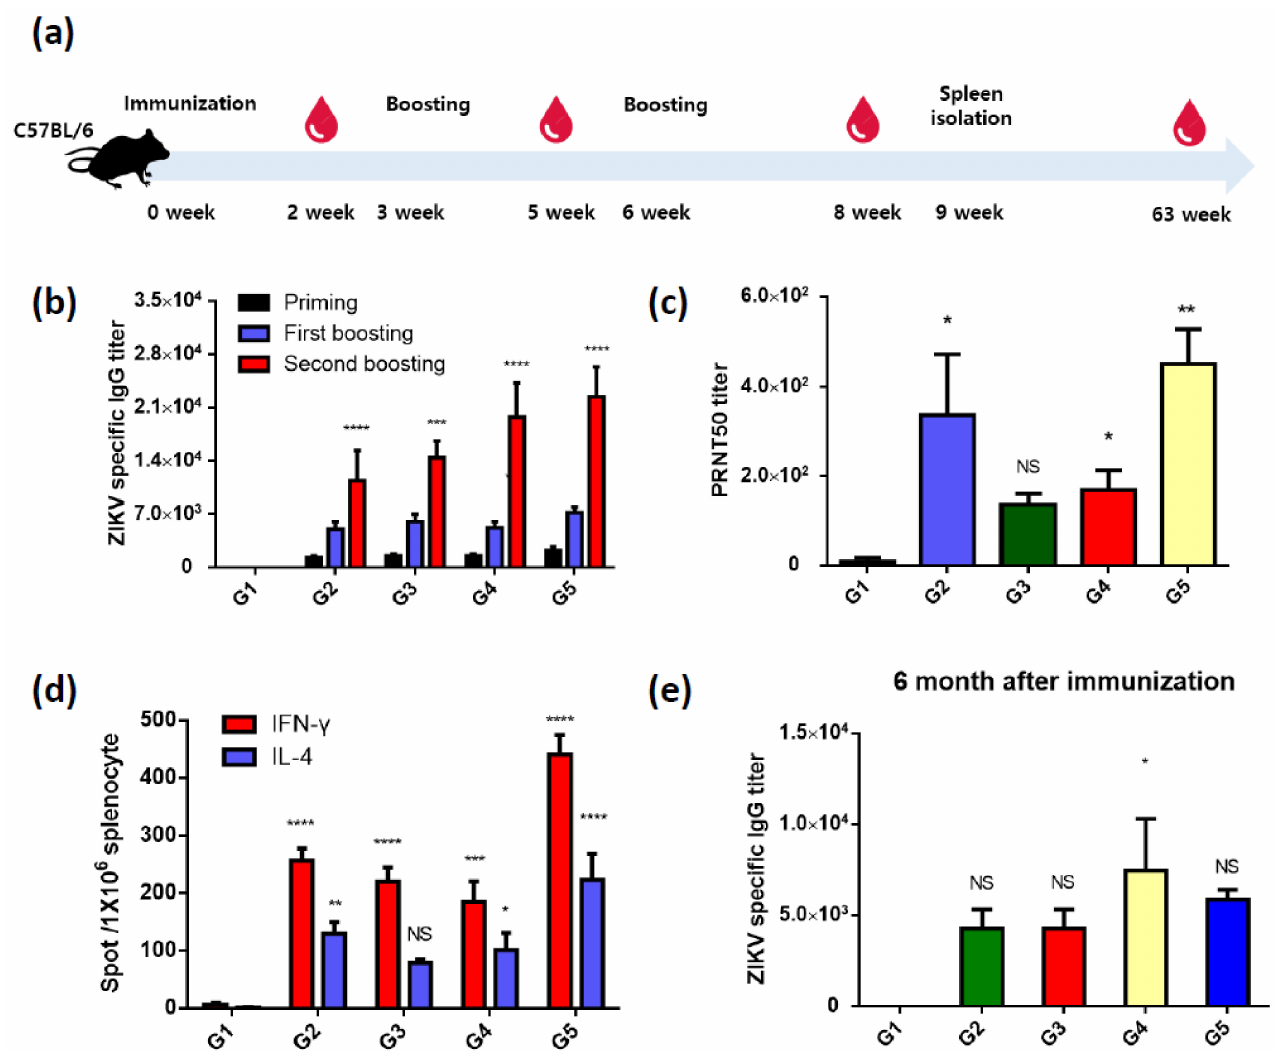
Figure 2. Immunogenicity in C57BL/6 mice vaccinated with ZIKV prM/E-expressing baculoviruses. ( a ) Schematic depiction of vaccination procedures in C57BL/6 mice. ( b ) Humoral immune responses were evaluated by detecting the ZIKV-specific IgG titer using indirect ELISA. ( c ) Generation of ZIKV-specific neutralizing antibodies was assessed by calculating the PRNT50 using immunized mouse sera. Mouse sera obtained after the 2nd boosting were analyzed. ( d ) T-cell-mediated immune responses were examined by IFN- γ and IL-4 ELISPOT analyses. Splenocytes isolated from vaccinated mice were stimulated with 1 × 10 5 PFU ZIKV MR766 strain. ( e ) The long-term immune memory response was assessed after 6 months of vaccination. **** p < 0.0001, *** p < 0.001, ** p < 0.01, * p < 0.05, NS, not significant, compared with the PBS